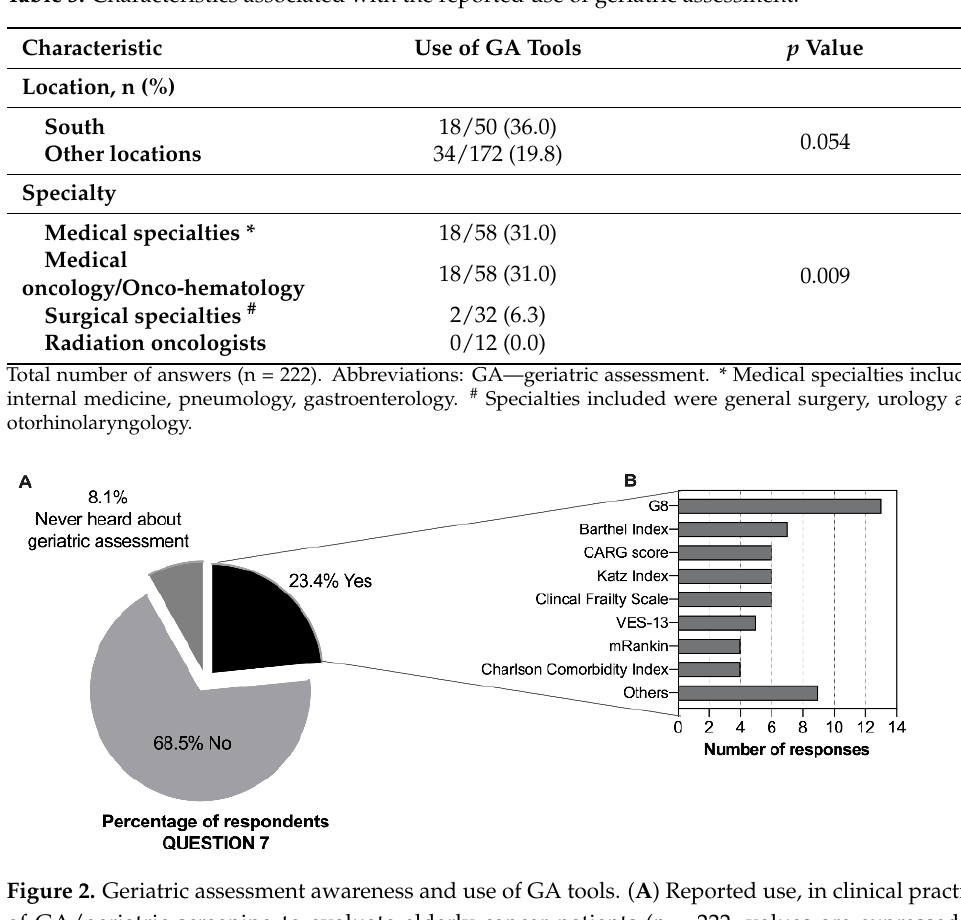
Table 3. Characteristics associated with the reported use of geriatric assessment.